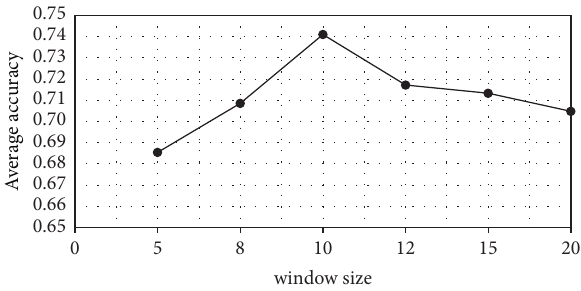
Figure 6: Average accuracies under different window sizes. Table 4: Disambiguation accuracies in the fourth group of experiments.